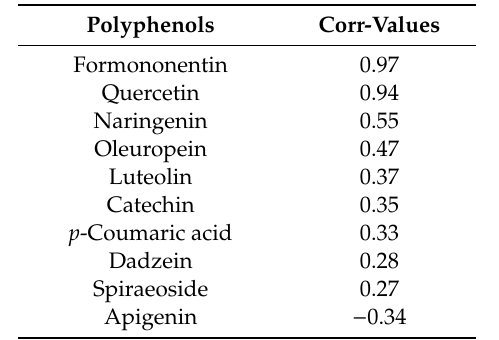
Table 4. Correlation coe ffi cients between the potential average antibacterial activity and polyphenols identified in the extracts of Ogliarola , Ravece and Ruvea antica EVOOs. The analysis was elaborated with respect to the percentage of each molecule present in the extracts and in an independent way with respect to the